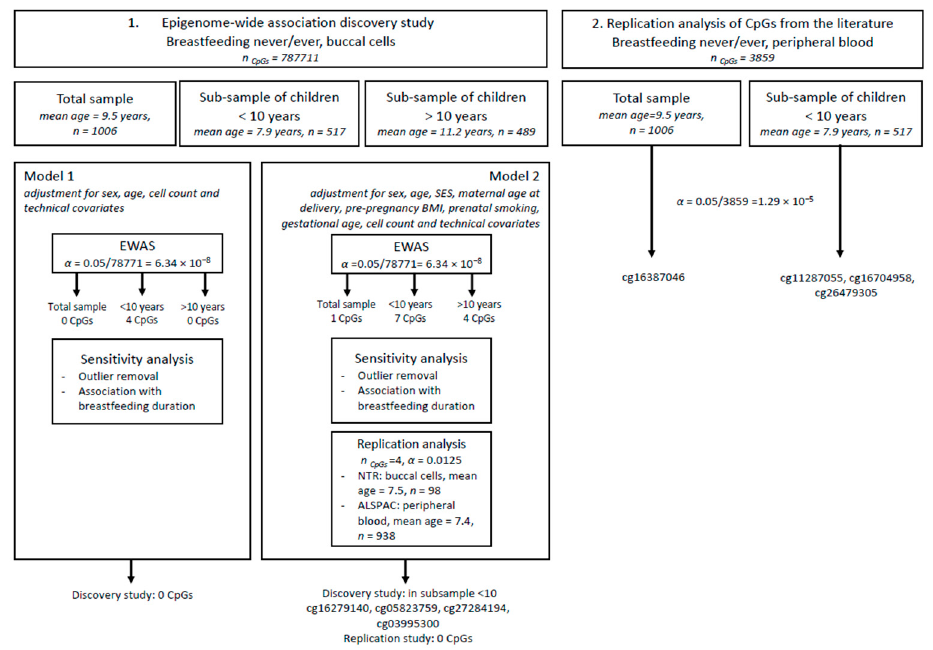
Figure 1. Flowchart of analyses.